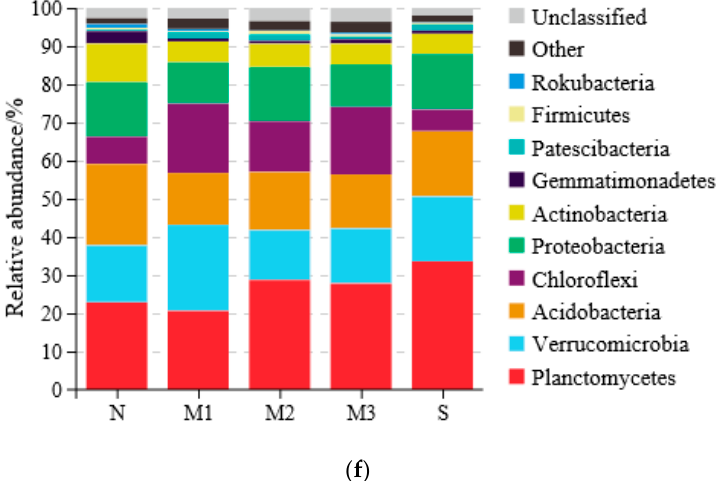
Figure 3. Ten most abundant phyla ( a ) and genera ( b ) amongst different Chinese fir provenances. Principal coordinate analysis of Bray distances amongst various samples at phylum ( c ) and genus ( d ) levels. Bacterial phylum and genus compositions of rhizosphere soil under different Chinese fir provenances. ( e ) Heat map showing the distribution of the 20 most abundant genera. ( f ) Distribution of the 10 most abundant phyla. N, northern belt; M1, western middle belt; M2, central middle belt; M3, eastern middle belt; S, southern belt.